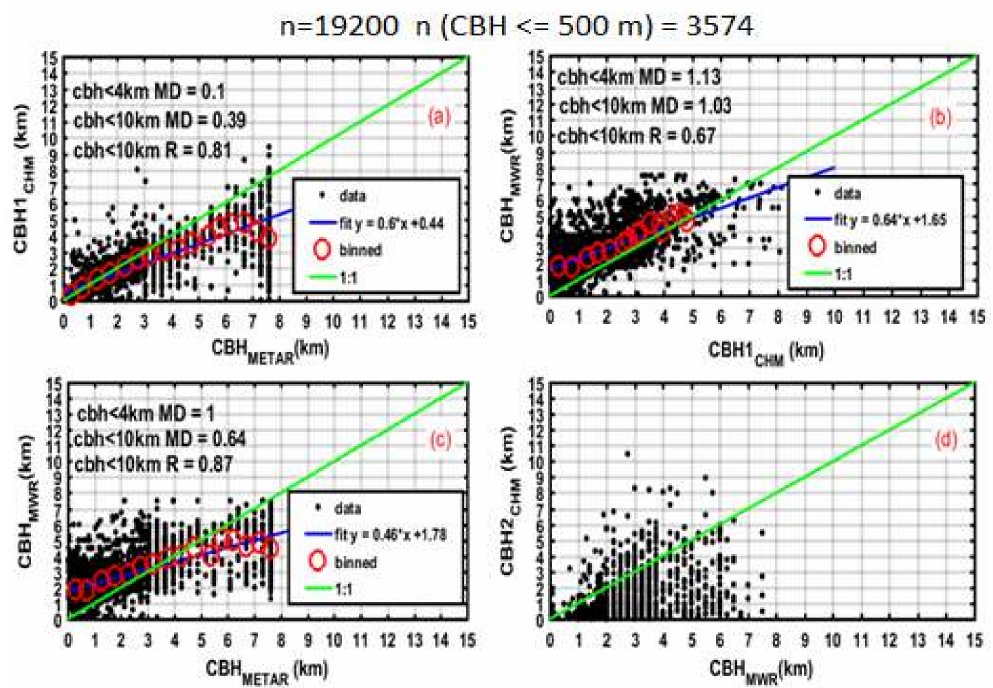
Figure 9. The lowest cloud base height (CBH1) measured using the CHM15 ceilometer (CBH1 CHM ) and MWR (CBH MWR ) plotted against human observation (CBH METAR ) (( a , c )), the CBH MWR data plotted against the CBH1CHM data ( b ), and the second cloud-base height (CBH2 CHM ) plotted against the CBH MWR data (Panel d ). The number of matched points ( n ) and the number of points for CBH <= 500 m are also